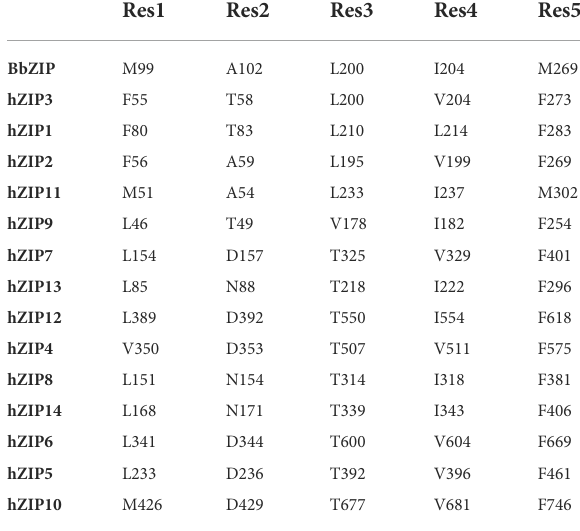
TABLE 2 Extracellular hydrophobic